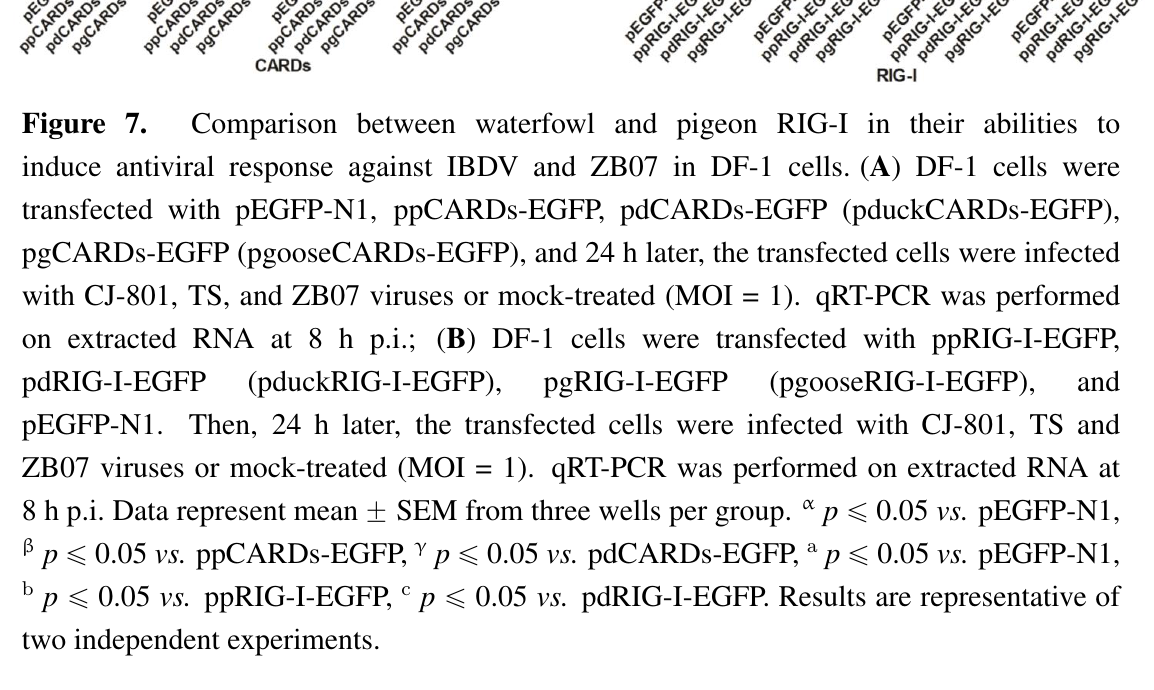
Figure 6. IBDV and ZB07 replication in pigeon CARDs and RIG-I transfected DF-1 cells. ( A – C ) DF-1 cells were transfected with pEGFP-N1, ppCARDs-EGFP and ppRIG-I-EGFP, and 24 h later, the transfected cells were infected with CJ-801, TS, and ZB07 viruses (MOI = 0.01). At 24 and 48 h p.i., the viral titers in the cell cultures were determined using TCID50. ( D ) DF-1 cells were transfected with pEGFP-N1, ppCARDs-EGFP and ppRIG-I-EGFP, and 24 h later, the transfected cells were infected with TS and ZB07 viruses. The RNA was extracted from cells for qRT-PCR at 8 h p.i. Data represent mean ± SEM from three wells per group. * p ≤ 0.05 vs. pEGFP-N1; ** p ≤ 0.01 vs. pEGFP-N1; *** p ≤ 0.001 vs. pEGFP-N1. Results are representative of two independent experiments. Viruses 2015 , 7